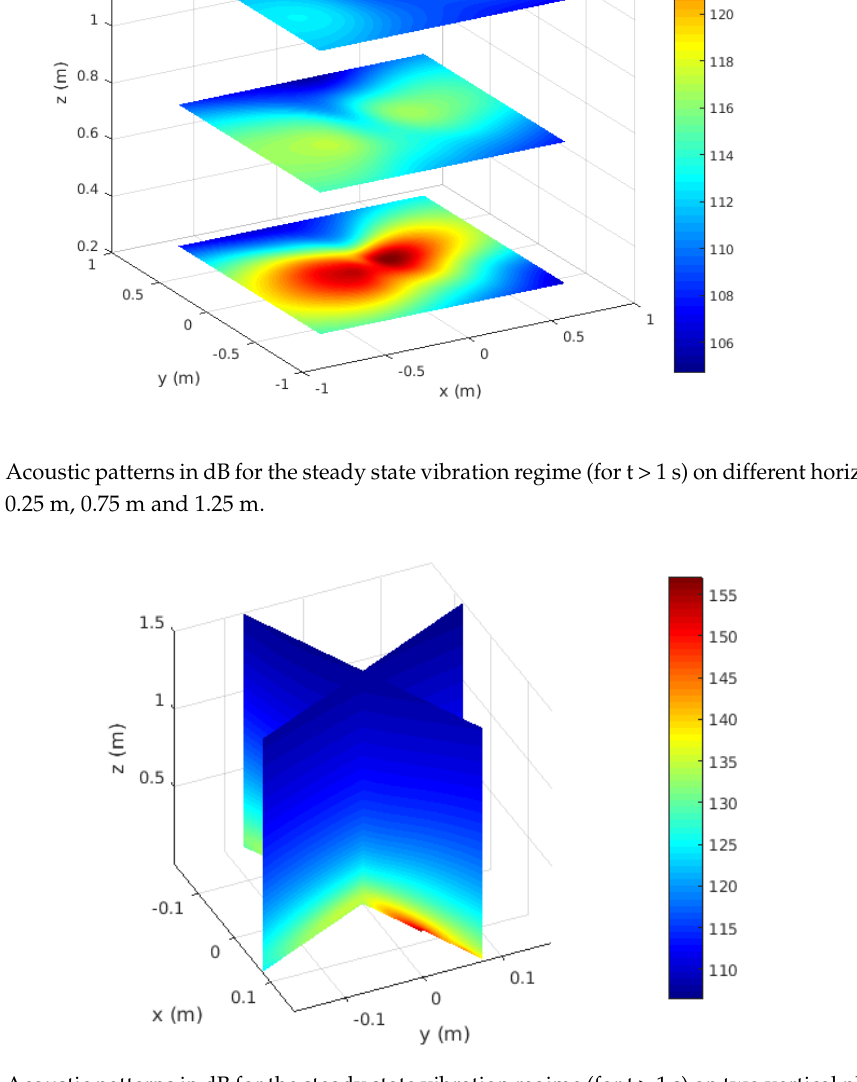
Figure 4. Acoustic patterns in dB for the steady state vibration regime (for t > 1 s) on two vertical